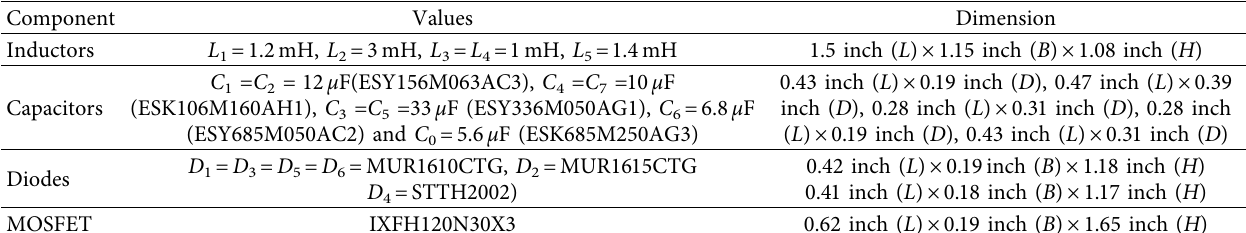
Table 1: Specifcations of the proposed converter.